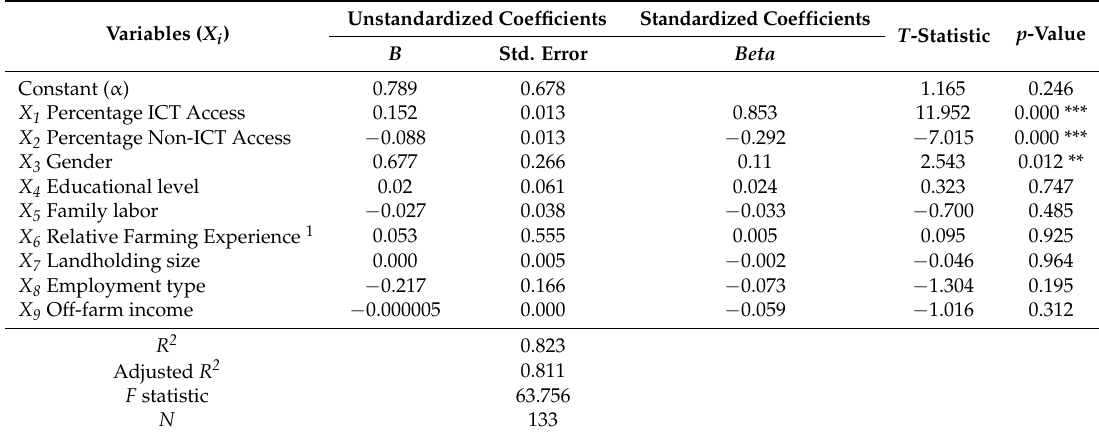
Table 5. Multiple regression results of the factors influencing level of access to production